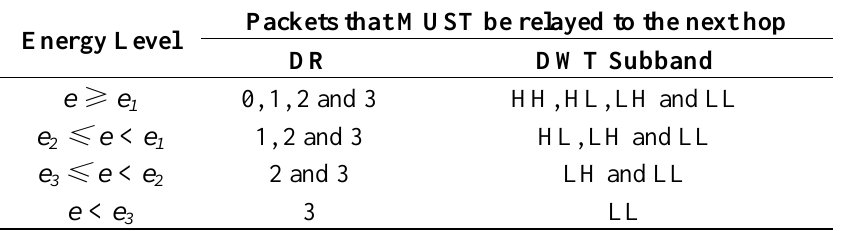
Table 6. Packet forwarding for the Data-relevance relaying approach.